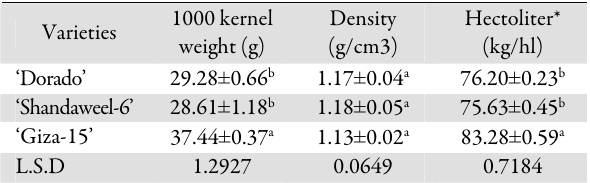
Table 3. WHC and OHC of milled sorghum at different treatments